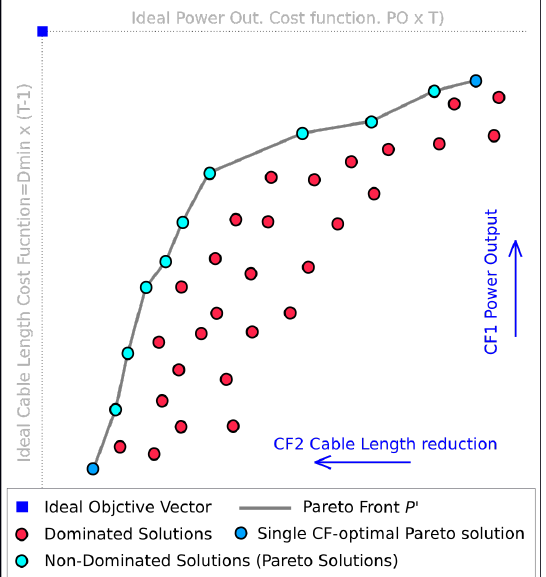
Figure 1. Scheme of the MO-WFLO objective space considered in this